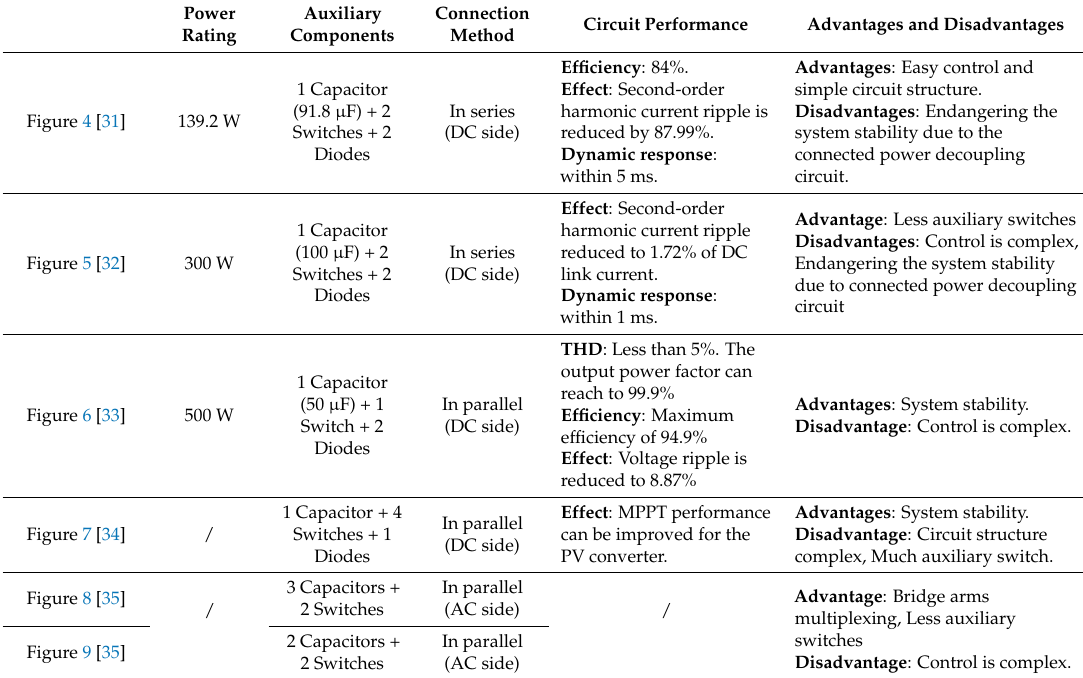
Table 1. Comparison of versatile power decoupling